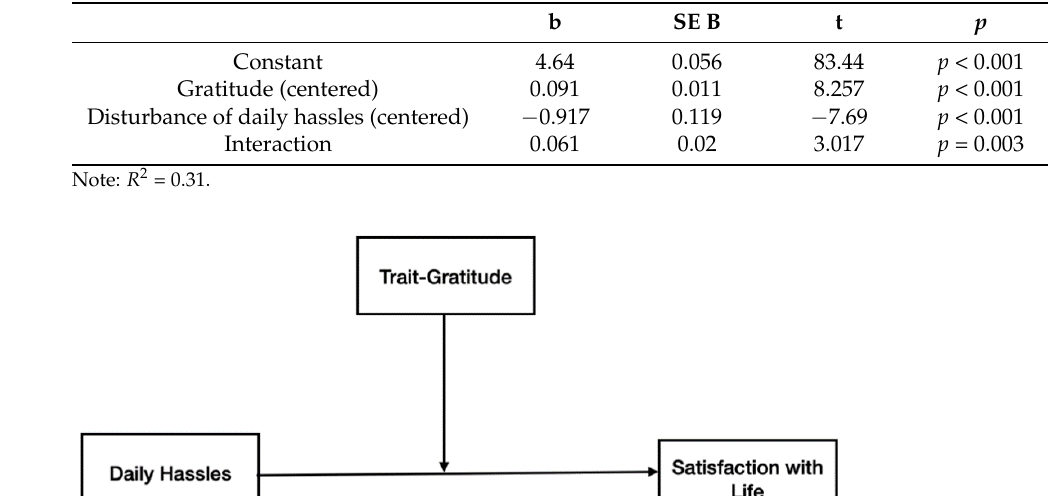
Table 3. Linear model of predictors of satisfaction with life.